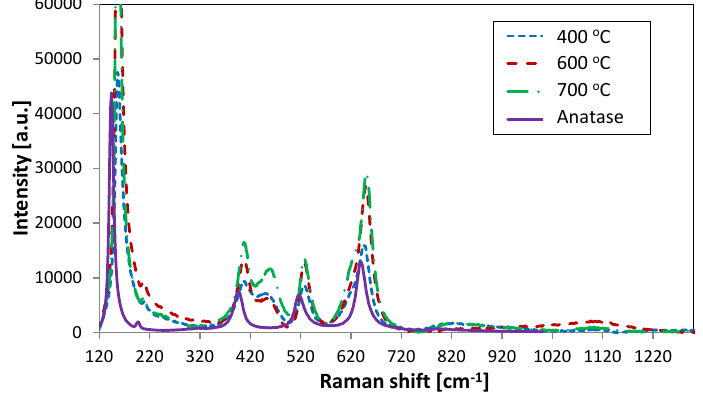
Figure 3. Raman spectra collected from samples annealed at 400, 600 and 700 °C and anatase